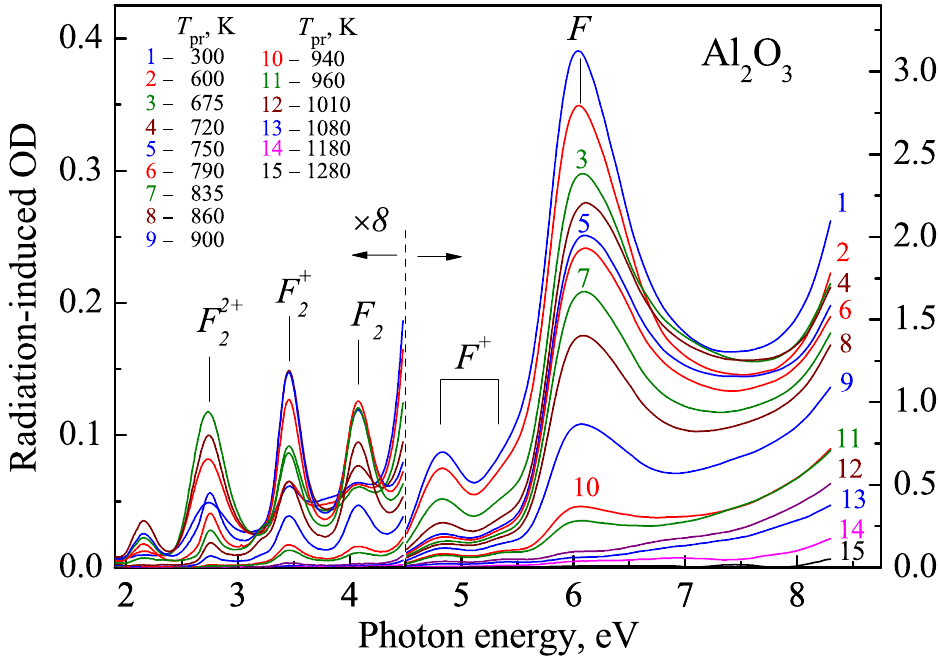
Figure 2. Spectra of RIOA for an Al 2 O 3 crystal with d = 0.09 mm after irradiation with fast fission neutrons (fluence Φ = 6.9 × 10 18 cm -2 , curve 1) or additional preheating of the same irradiated sample to different temperatures T pr . All spectra are measured at